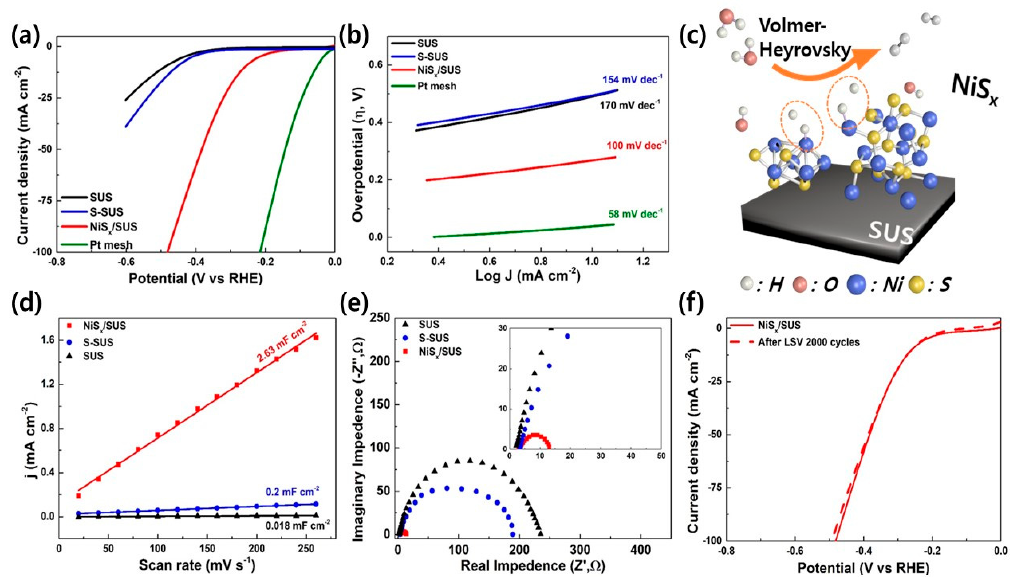
Figure 5. Hydrogen evolution reaction (HER) performances of prepared electrodes. ( a ) Linear scan voltammetry (LSV) in the range of 0 to − 0.6 V vs reversible hydrogen electrode (RHE) in 1 M KOH; ( b ) Tafel plots; ( c ) illustration for hydrogen evolution reaction of NiS x / SUS; ( d ) increased current density in non-faradaic region depending on the increasing scan rates for double layer capacitances of electrodes; ( e ) Nyquist plot at − 0.4 V vs RHE; and ( f ) LSV 2000 cycles of NiS x /SUS for 33 h.